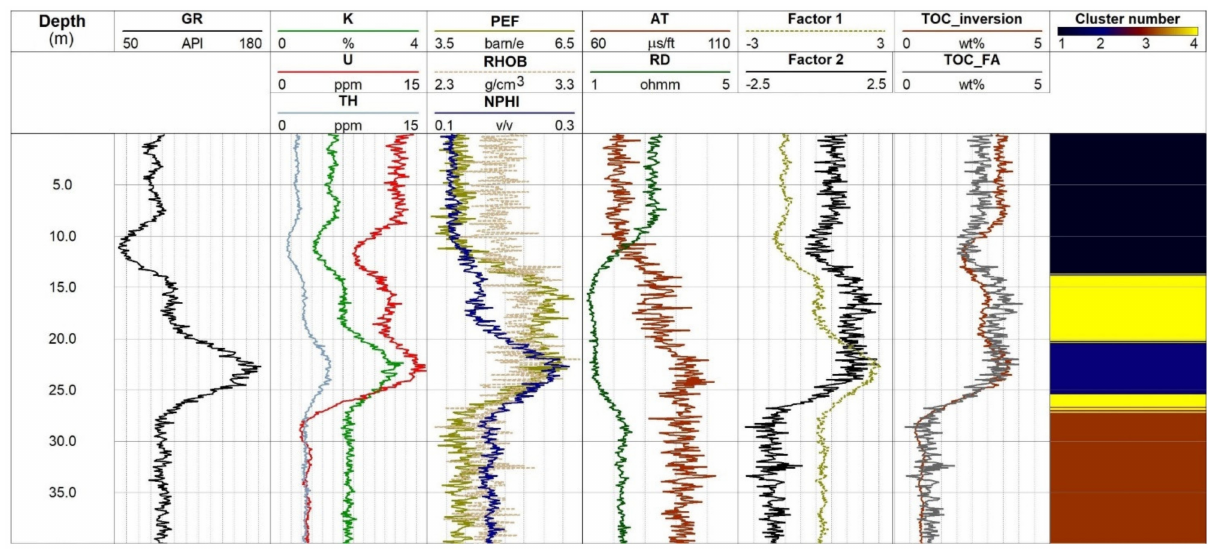
Figure 2. Result of factor analysis in Well 1. Denotations are as follows: natural gamma-ray (GR), spectral gamma-ray (K, U, TH), photoelectric absorption index (PEF), bulk density (RHOB), neutron porosity (NPHI), acoustic travel-time (AT), deep resistivity (RD), TOC log from interval inversion (TOC_inversion) and TOC log from factor analysis (TOC_FA). The shale factor is Factor 1; the organic factor is Factor 2. The last track shows the depth distribution of four identified clusters. Table 3. Factor loadings rotated using the varimax algorithm for Well